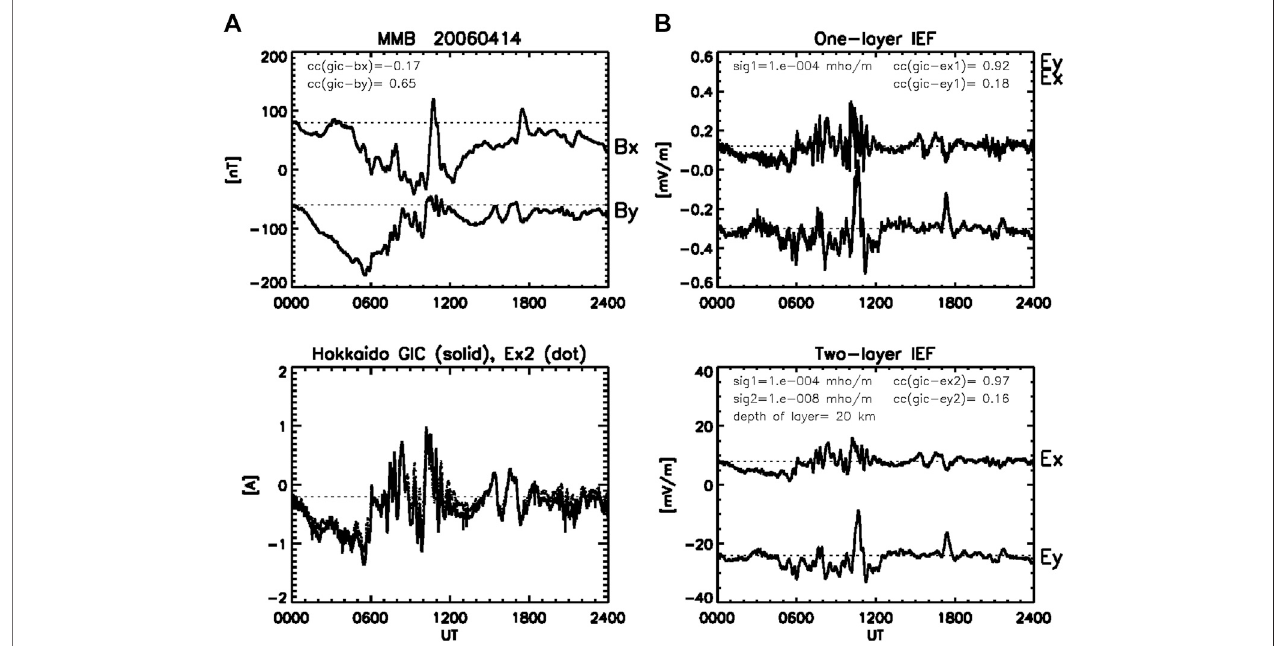
FIGURE 5 | (A) B x , B y and GIC observed at MMB, and (B) E x and E y calculated in the one- and two-layer models for the geomagnetic storm events with the main phase (00-10 UT, 09-19 MLT) followed by the recovery phase (10-18 UT, 19-03 MLT) superimposed by the substorm positive bay (10-11 UT, 19-20 MLT). The parameters and formats of the plots are the same as in Figure 1 .